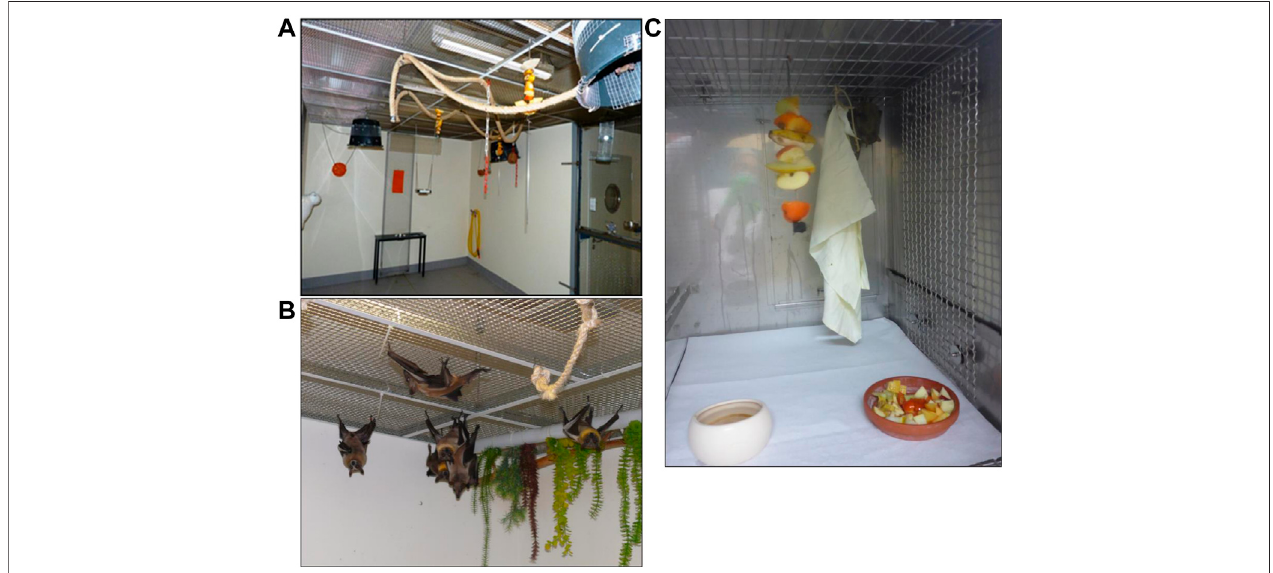
FIGURE 1 | Housing and husbandry in the aviary (A) R. aegyptiacus, (B) E. helvum , and (C) R. aegyptiacus in a cage during an infection study. The aviary offers severalpossibilitiestoclimb, fl yandhide,allowingbatstoshowtheirnaturalbehavior.Duringinfectionstudies,cagedanimalscanclimbandhide,andcanevenminimally fl y. Social interactions are possible in both settings. In both settings, the daylight cycle was from 6:00 to 18:00, with a 15 min dimming phase between day and night cycles.